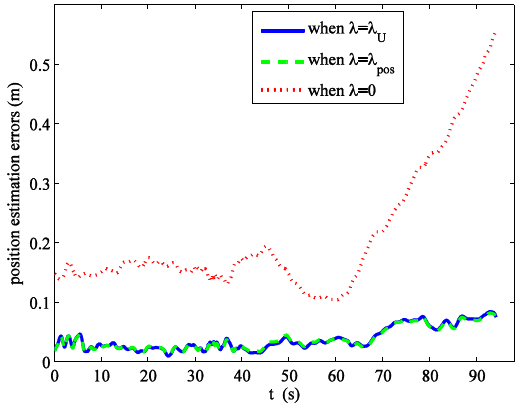
Figure 3. Mean errors of position estimates versus λ in logarithmic scale.